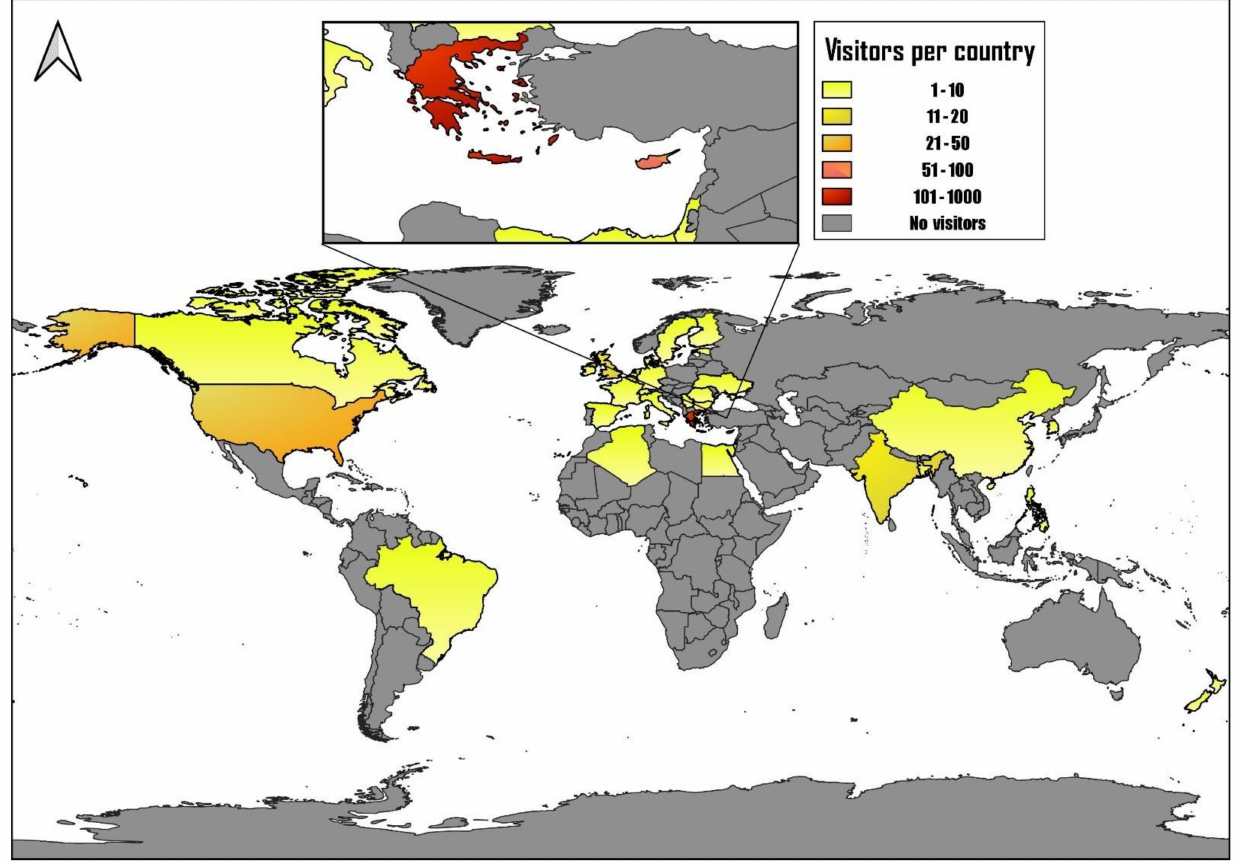
Figure 2. Alientoma users’ country